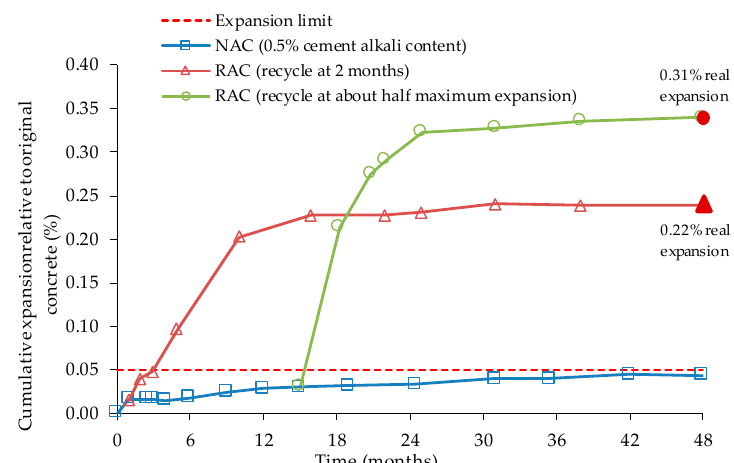
Figure 4. Expansion of high alkali mixes with coarse RA, from low alkali OC, and high alkali cement in ASTM C 227, adapted from [74].